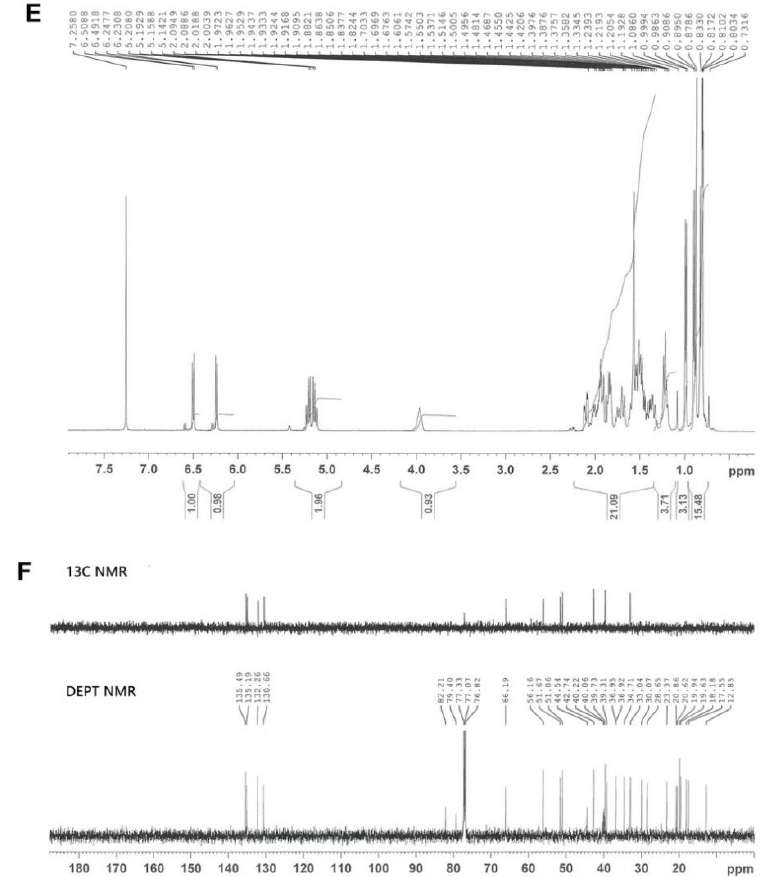
Figure 1. Preparation and identification of ergosterol peroxide (EP). ( A ) Paecilomyces cicadae was added and cultured. ( B ) Fermentation products of P. cicadae . ( C ) Mycelium of P. cicadae . (1 D ) Target fraction and EP had a single peak at 13 min by HPLC. ( E ) Structure of the EP products was determined by 1 H NMR spectroscopy. ( F ) Identification of EP products by 13 C and DEPT NMR spectroscopy.